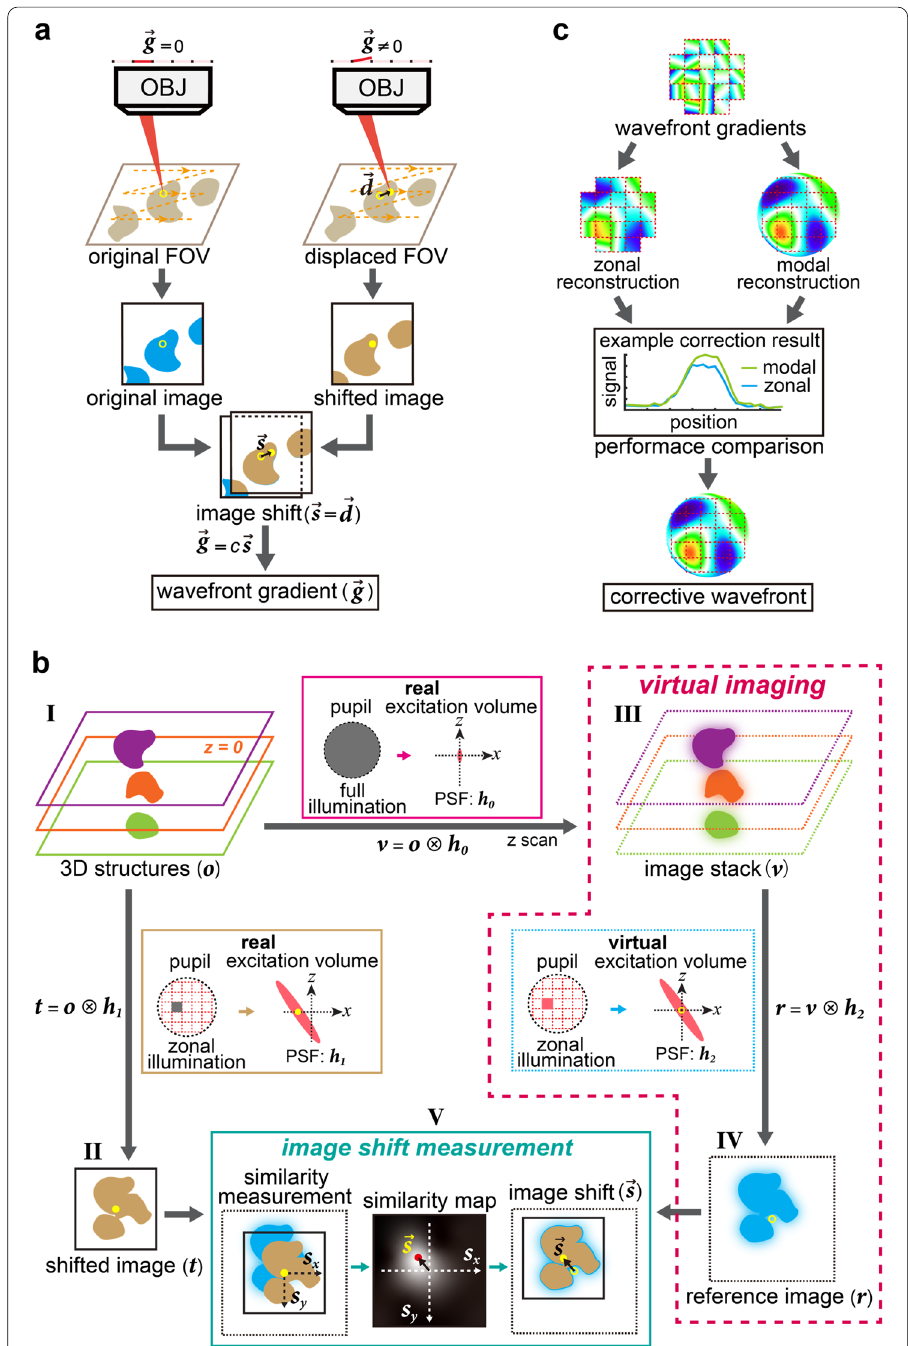
Fig. 1 Schematic of virtual-imaging-assisted wavefront measurement. a Principle of image-based wavefront gradient measurement. b Measuring the gradient of a wavefront segment in biological tissues via virtual imaging. (I) Three-dimensional (3D) biological structures. (II) Shifted image acquired under zonal illumination. (III) Image stack acquired under full-pupil illumination, which is also the sample for virtual imaging. (IV) Reference image constructed by virtual imaging. (V) Image shift measurement between the test image and the reference image. c Corrective wavefront